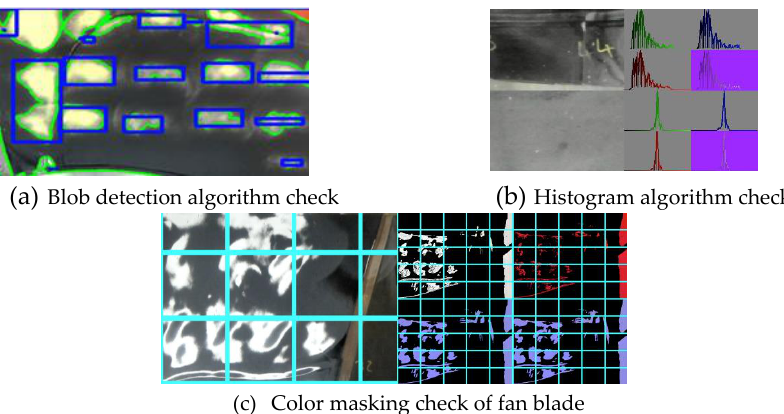
Figure 11. Fan-blade regions of interest for concave side. Sensors 2020 , 20 ,